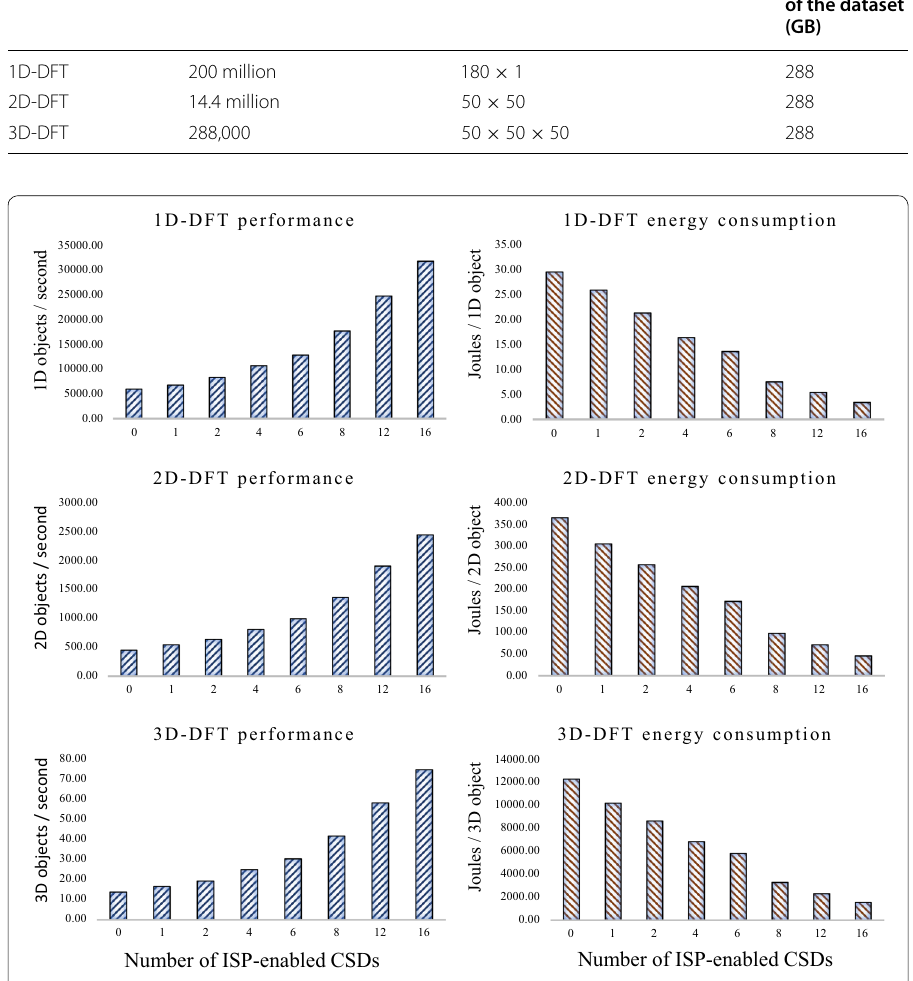
Fig. 13 DFT benchmarks performance and energy consumption